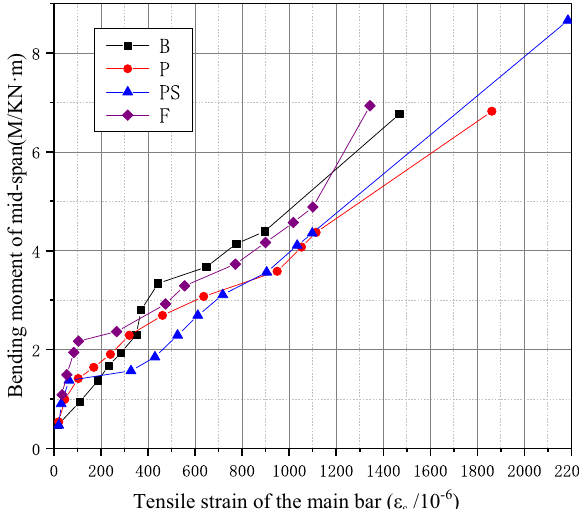
Figure 7: Tensile strain of the main bar in bending under various loads.